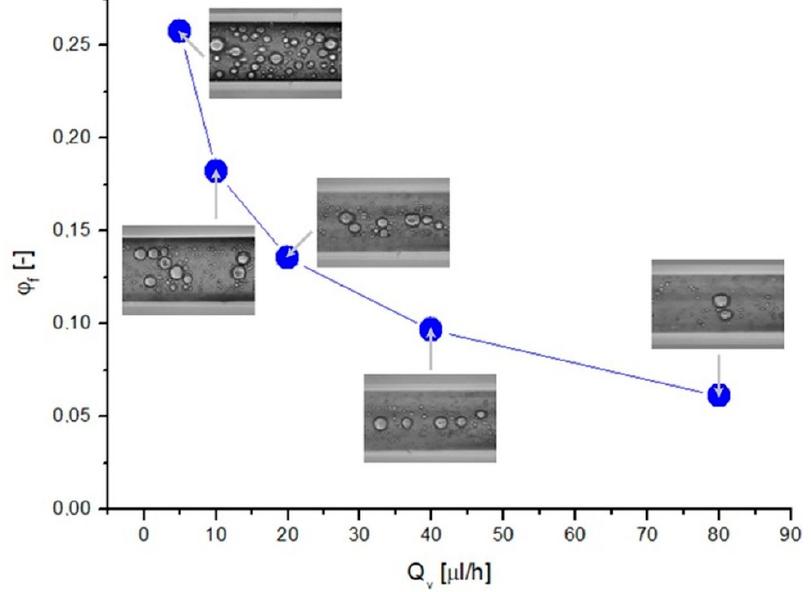
Figure 4. Dependence of the degree of compaction of the emulsion with a concentration of 0.05 on the liquid flow rate.